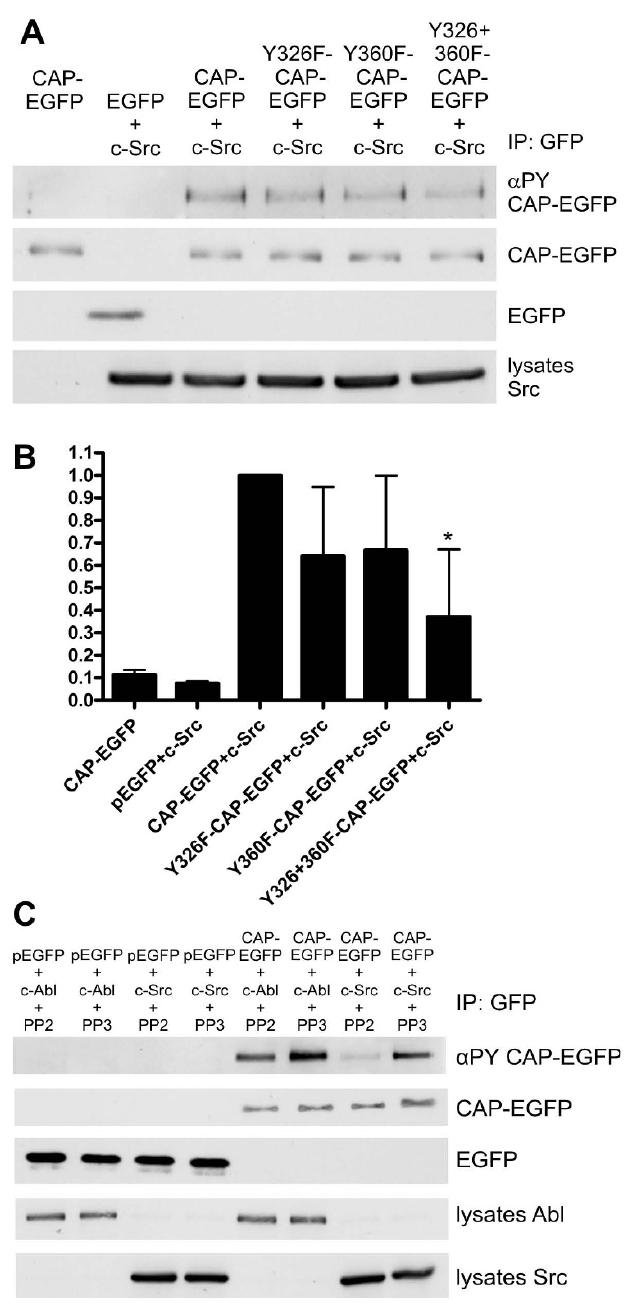
Figure 8 Tyr326 and Tyr360 are the major phosphorylation sites of Src . A: CAP-EGFP and its mutant variants were transfected into HeLa cells together with c-Src and the phosphorylation of CAP was analyzed after immunoprecipitation. Tyr phosphoryla- tion of the Y326F and Y360F mutant was reduced as compared to the WT CAP. An even lower level of phosphorylation could be detected for the Y326F+Y360F mutant. B: Quantification of the phosphorylation of CAP upon c-Src copexpression. Shown is the summary of the results of four independent experiments, error bars show standard deviation. C: c-Abl or c-Src was transfected into HeLa cells together with CAP-EGFP or EGFP, and the cells were treated with the Src inhibitor PP2, which does not inhibit Abl kinase at this concentration, or with non-inhibiting analogue PP3. In c-Abl transfected cells, inhibition of Src activity results in reduced phosphorylation of CAP, whereas in c-Src transfected cells, no phosphorylation could be detected after PP2